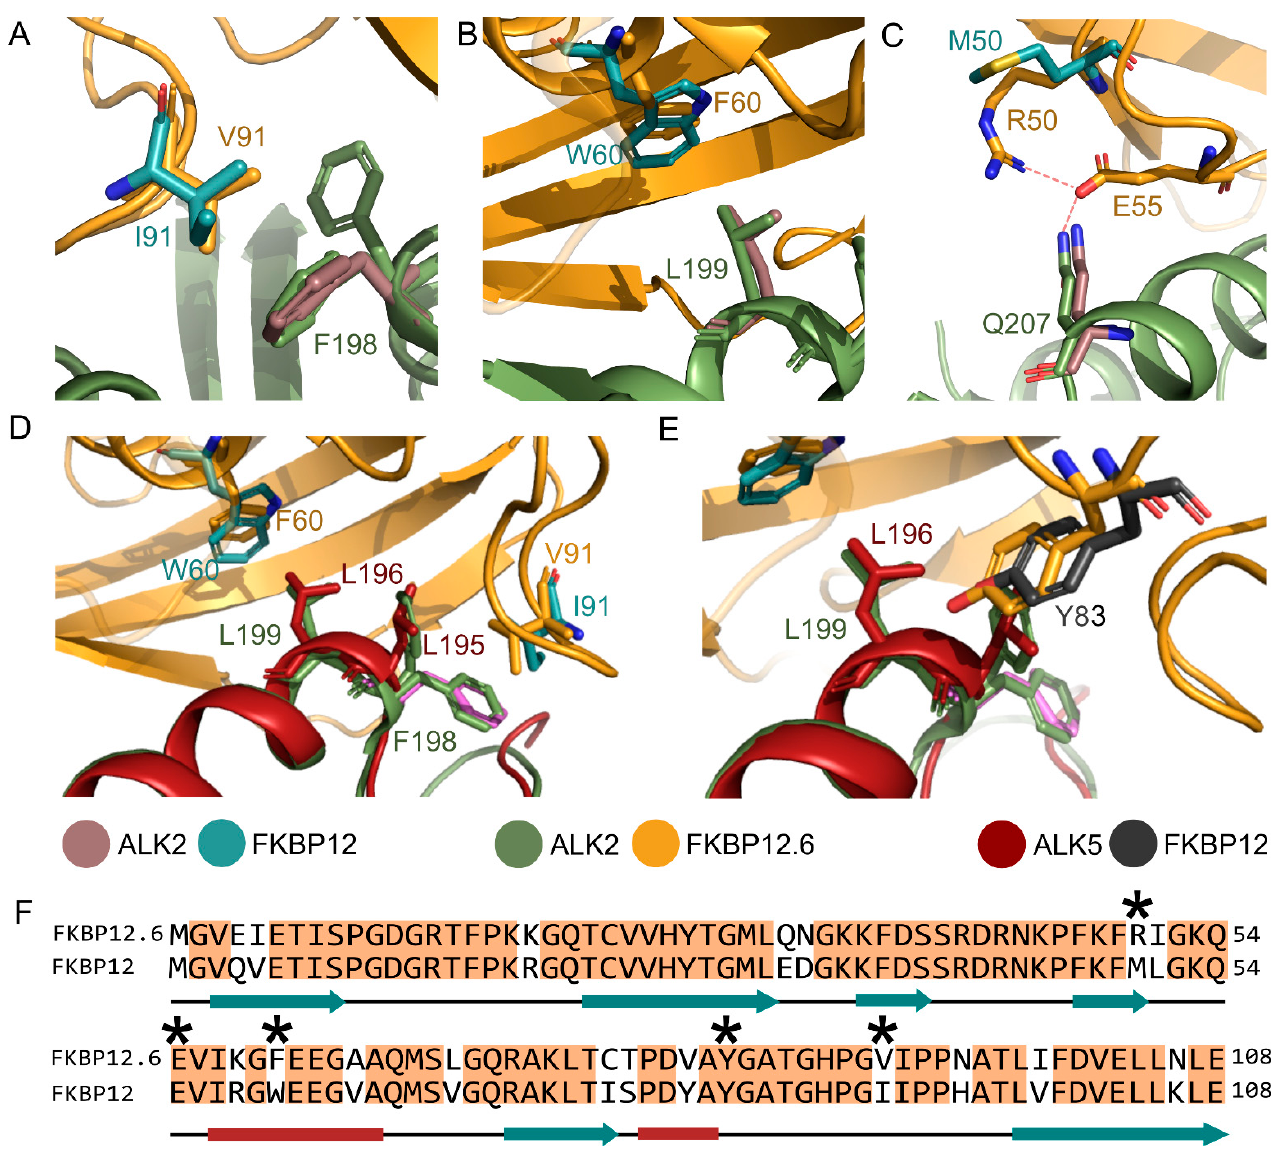
Figure 5. Structural variations between ALK2 binding to FKBP12 and FKBP12.6. Structures of ALK2-FKBP12 (PDB 3H9R [14]), ALK2-FKBP12.6 (PDB 4C02), and ALK5-FKBP12 (1B6C [12]) were superimposed and are displayed in the indicated colors. Different views of the FKBPs binding to the α GS2 helices of ALK2 and ALK5 are shown highlighting selected side chain and conformational differences. ( A ) FKBP12 Ile91 is replaced by Val91 in FKBP12.6, which packs against two distinct conformations of ALK2 Phe198. ( B ) FKBP12 Trp60 is replaced by Phe60 in FKBP12.6 and packs against ALK2 Leu199. ( C ) FKBP12.6 Glu55 and Arg50 can form an intramolecular interaction in addition to Glu55 interaction with ALK2 Gln207. ( D ) ALK2 Phe198-Leu199 are replaced by Leu195-Leu196 in ALK5. Both ALK5 leucines occupy the hydrophobic FK506-binding pocket in the FKBP12 co-structure (red). In the equivalent ALK2-FKBP12 structure, ALK2 Phe198 (magenta) folds outside this pocket. The ALK2-FKBP12.6 co-structure shows ALK2 Phe198 (green) adopting both conformations. ( E ) The conserved FKBP residue Tyr83 packs more closely to the α GS2 helix in the ALK2 co-structures compared to the ALK5 co-structure. ( F ) Sequence alignment of FKBP12 and FKBP12.6 highlighting conserved residues and secondary structural elements. Side chains displayed in the figure are denoted by an